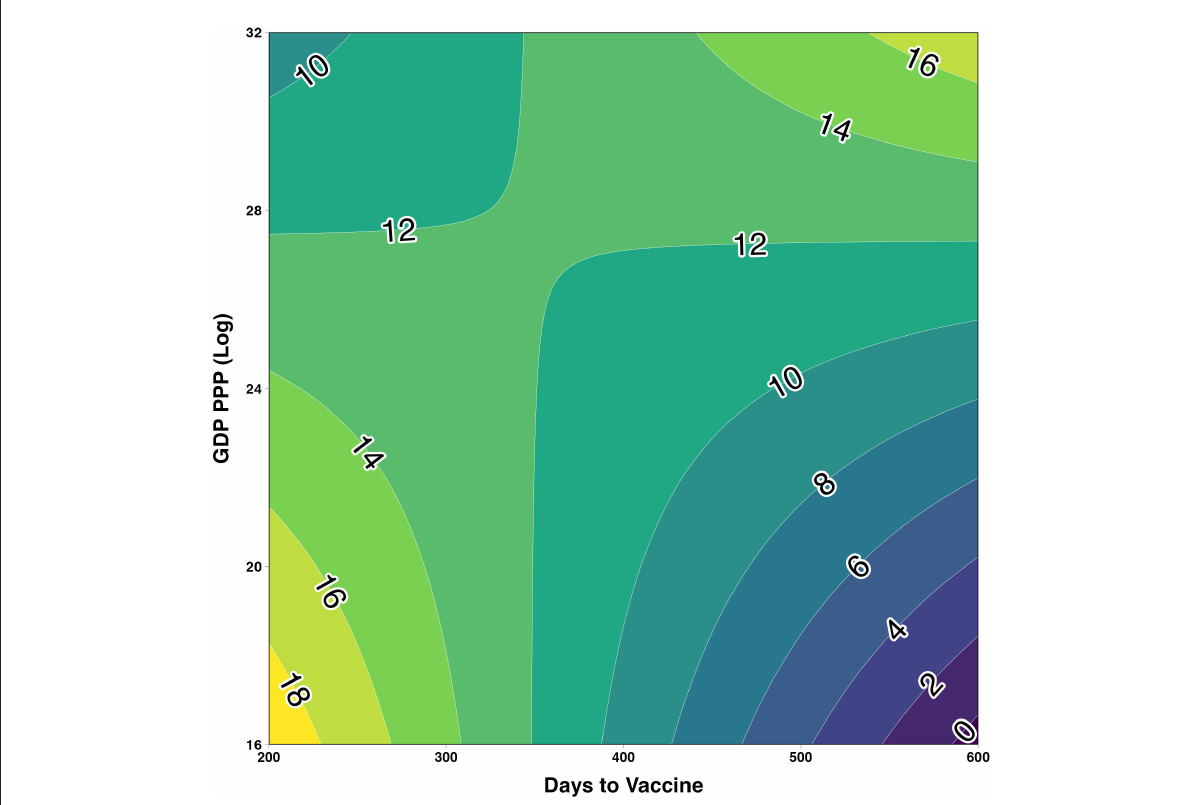
FIGURE2 Contour plot assessing the two-way interaction between log-GDP PPP and days to first COVID-19 vaccine on cumulative cases estimated using multiple linear regression and adjusted for 2021 population size, median age, and testing data availability